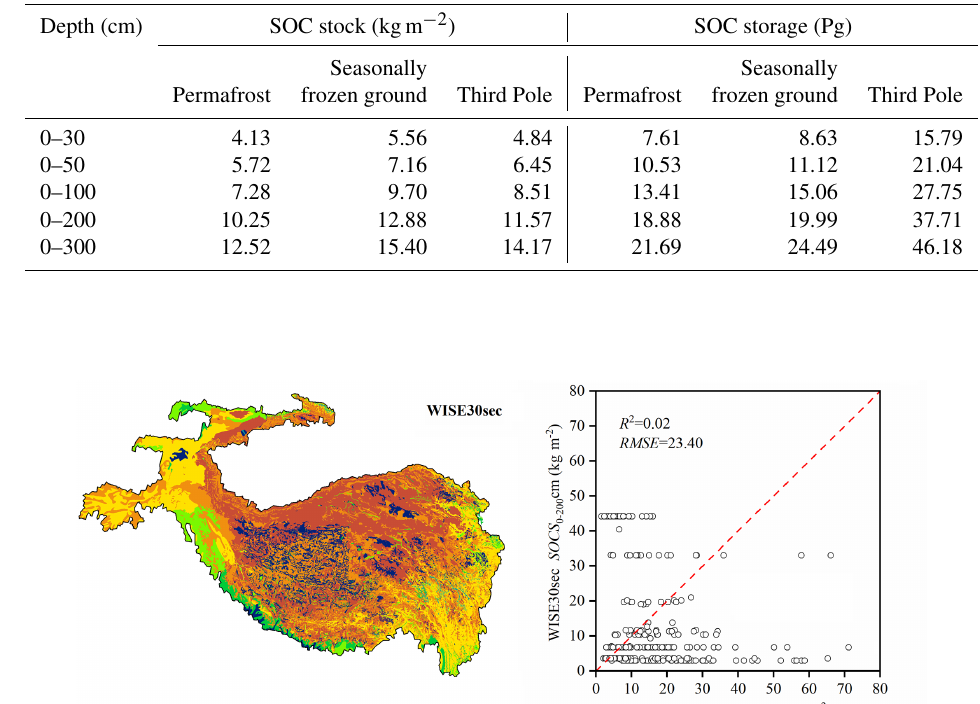
Table 3. Summary of the estimated mean SOC stocks and storages in permafrost and seasonally frozen ground of the Third Pole.